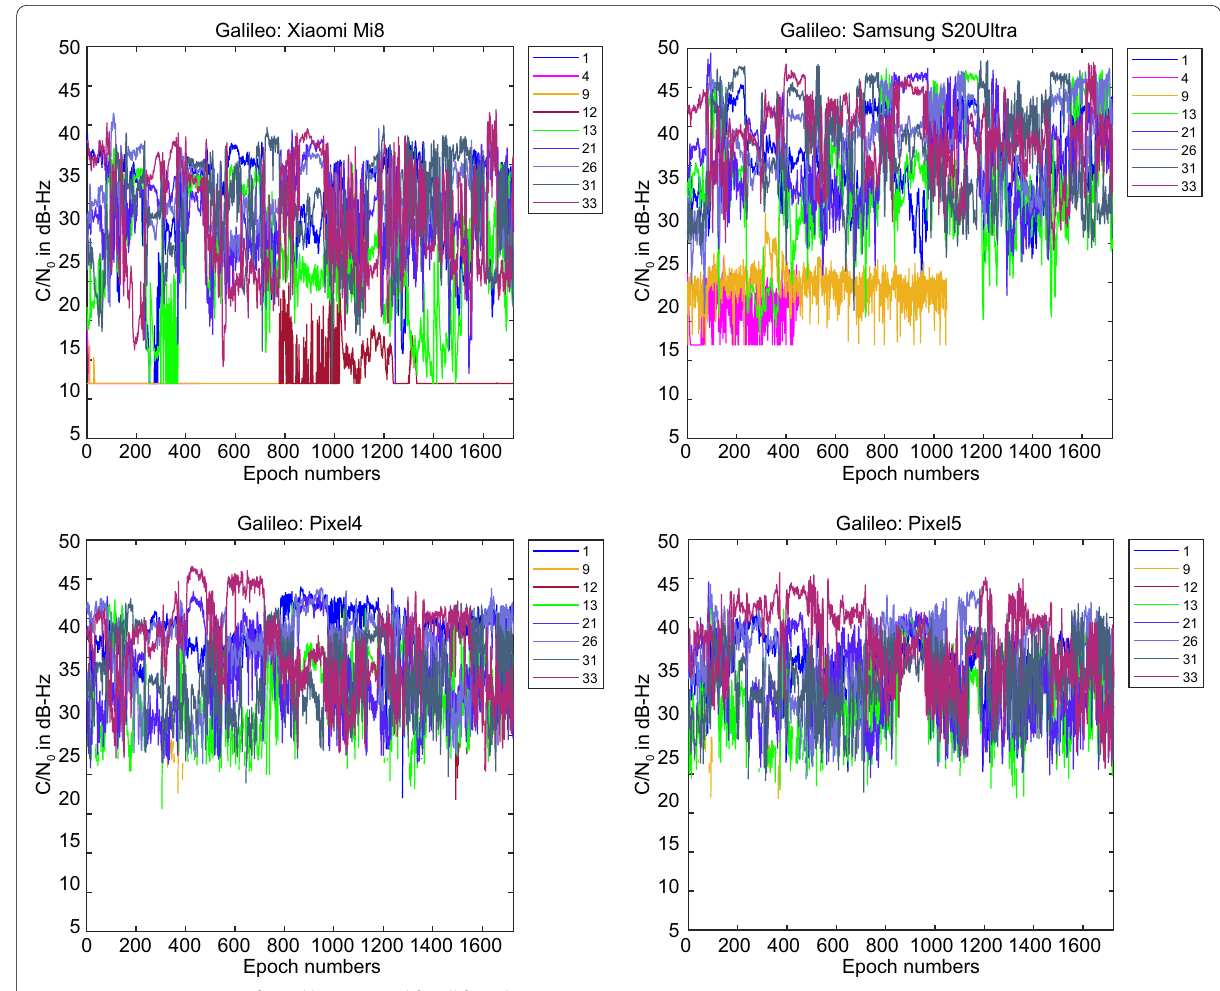
Fig. 7 C/N 0 measurements for Galileo E1 signal for all four